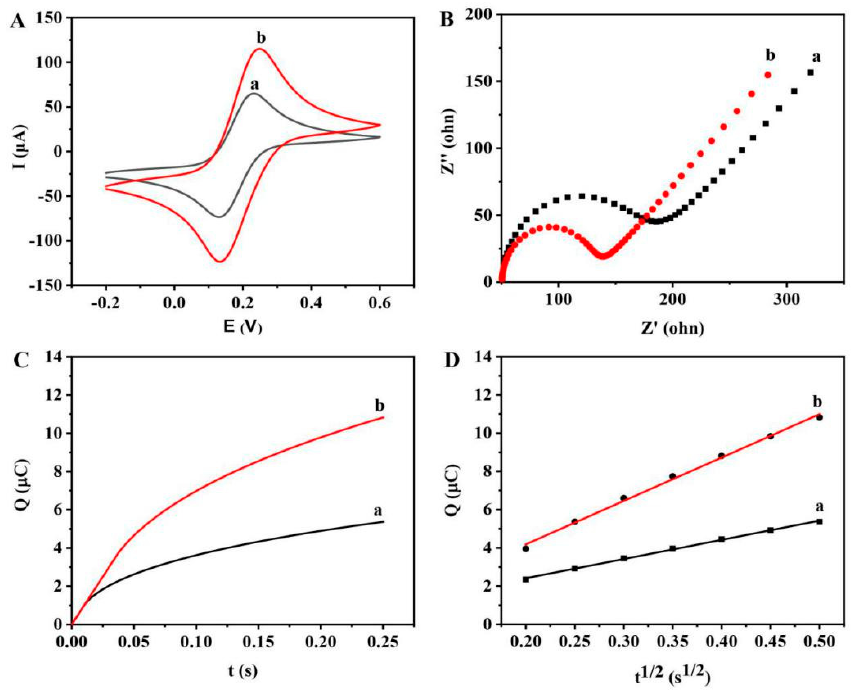
Figure 4. ( A ) Cyclic voltammograms of bare GCE (a) and poly([V 2 C 4 (mim) 2 ]Br 2 )/GCE (b) in 0.1 M KCl containing 5.0 mM [Fe(CN) 6 ] 3 − /4 − . ( B ) Nyquist plots of bare GCE (a) and poly([V 2 C 4 (mim) 2 ]Br 2